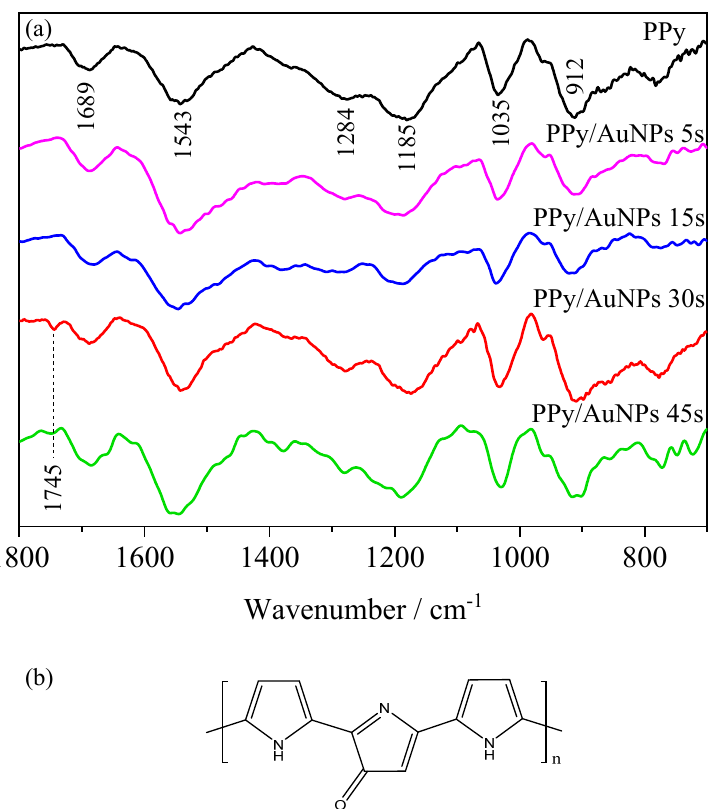
Figure 3. ( a ) FTIR spectra of PPy (black line), PPy/AuNPs 5 s (pink line), PPy/AuNPs 15 s (red line), PPy/AuNPs 30 s (blue line) and PPy/AuNPs 45 s (green line) modified graphite electrodes. ( b ) Structure of overoxidized PPy [32,33].